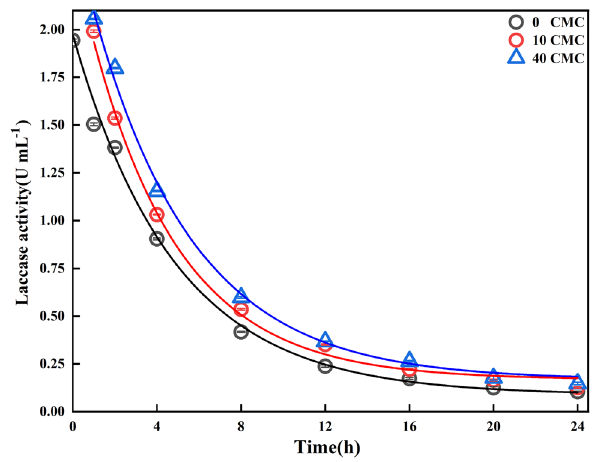
Figure 4. Changes of laccase activity in LMS-HOBt at different times.